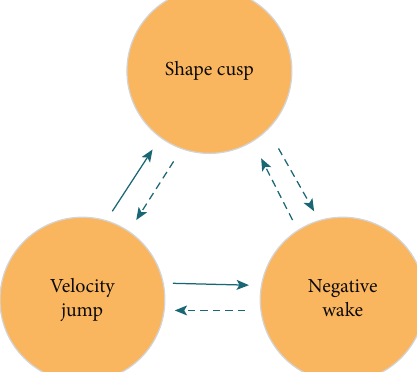
Figure 12: The relationship among the three peculiar phenomena of viscoelastic fluids discussed in this review.